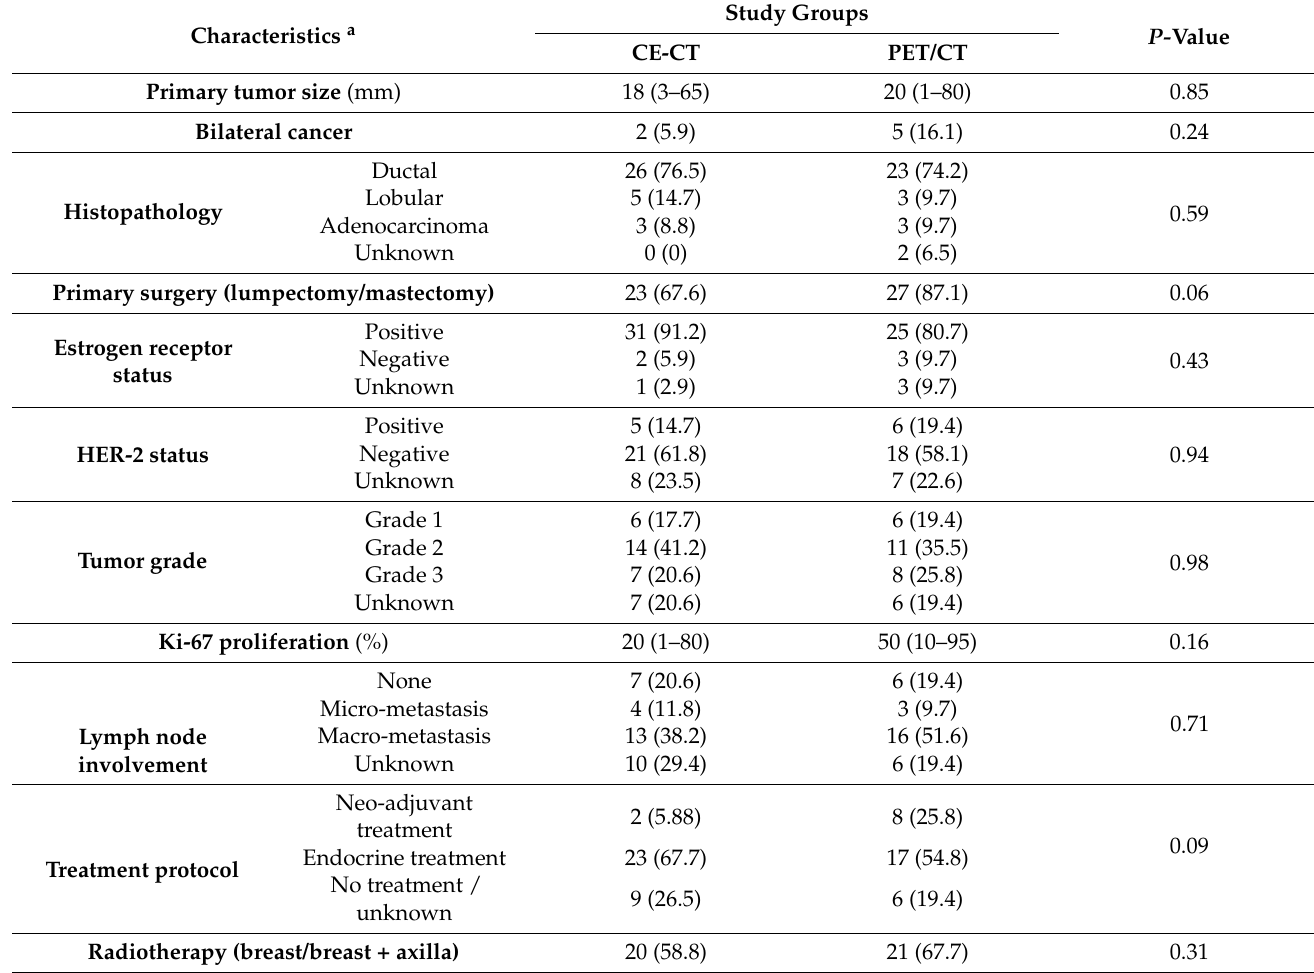
Table 1. Clinicopathological characteristics of primary breast